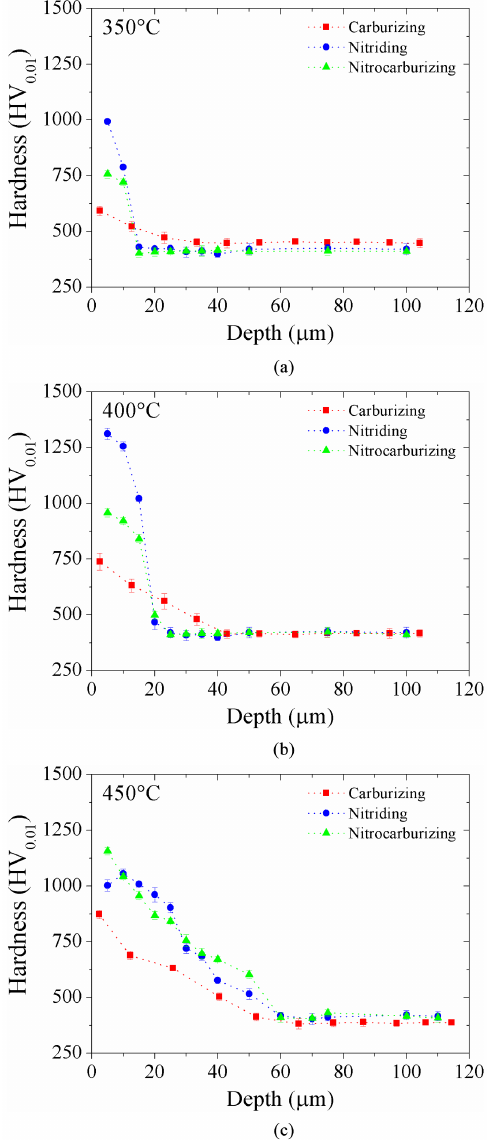
Figure 5. Microhardness profiles of samples treated by carburizing, nitriding and nitrocarburizing during 8 h at: (a) 350; (b) 400 and (c) 450